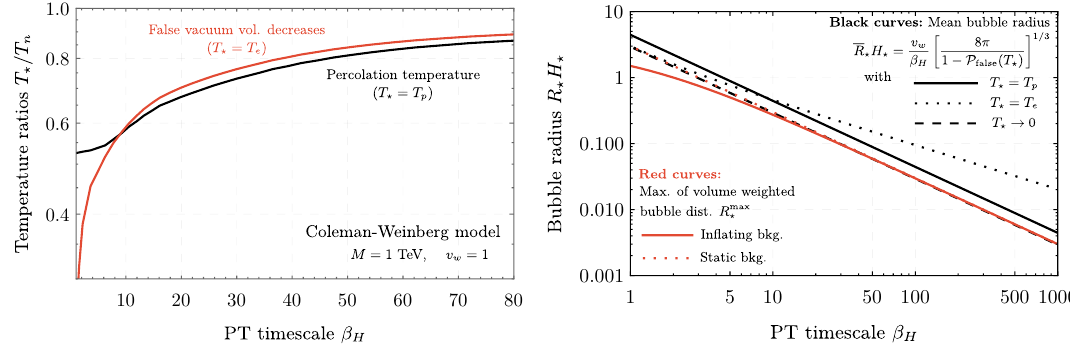
Figure 9 . Temperature and typical bubble size at collisions as a function of the PT timescale. Left : here we show how T p (black) and T e (red) vary with respect to the nucleation temperature as a function of the PT timescale. We observe that T p is an accurate measure of the PT completing except for extremely small values of β H . Right : we show the resulting determination of R ? as a function of β H , for a number of different approximations. The main message is that for β H & 10 , the PT is sufficiently fast that the background expansion can be ignored while the maximum of the volume weighted distribution also coincides with the mean bubble size in this